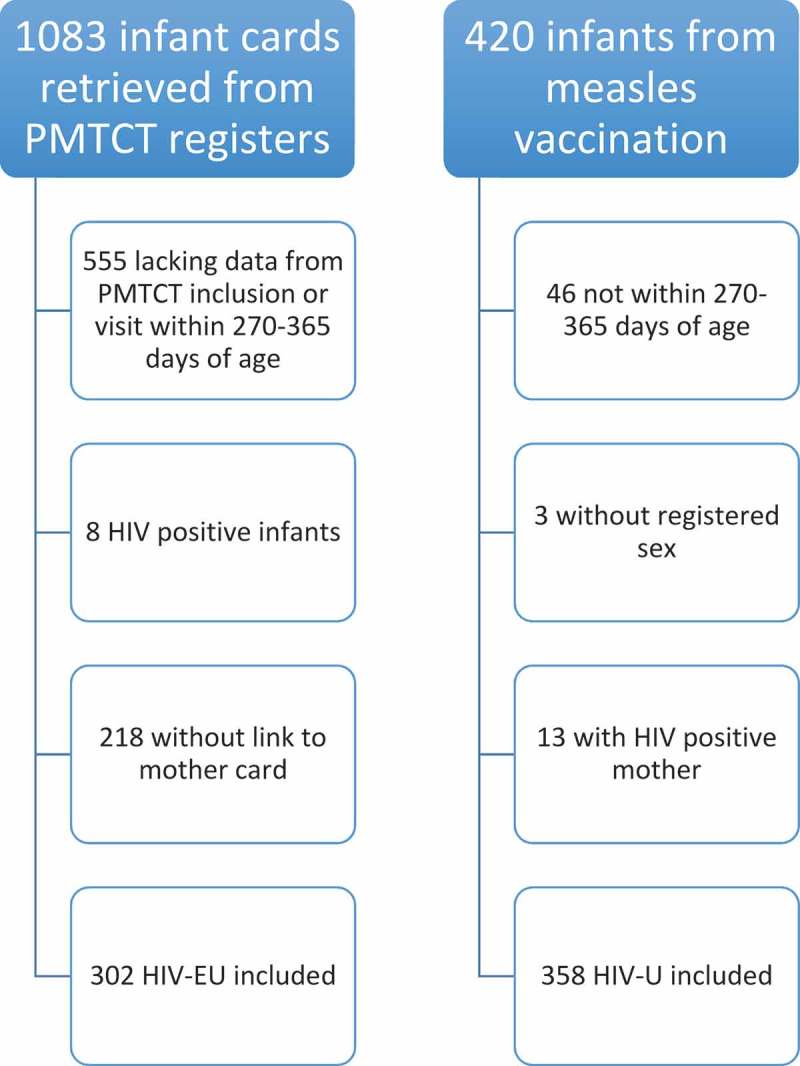
Exclusion process for HIV exposed uninfected (HIV-EU) and HIV unexposed (HIV-U) infants.